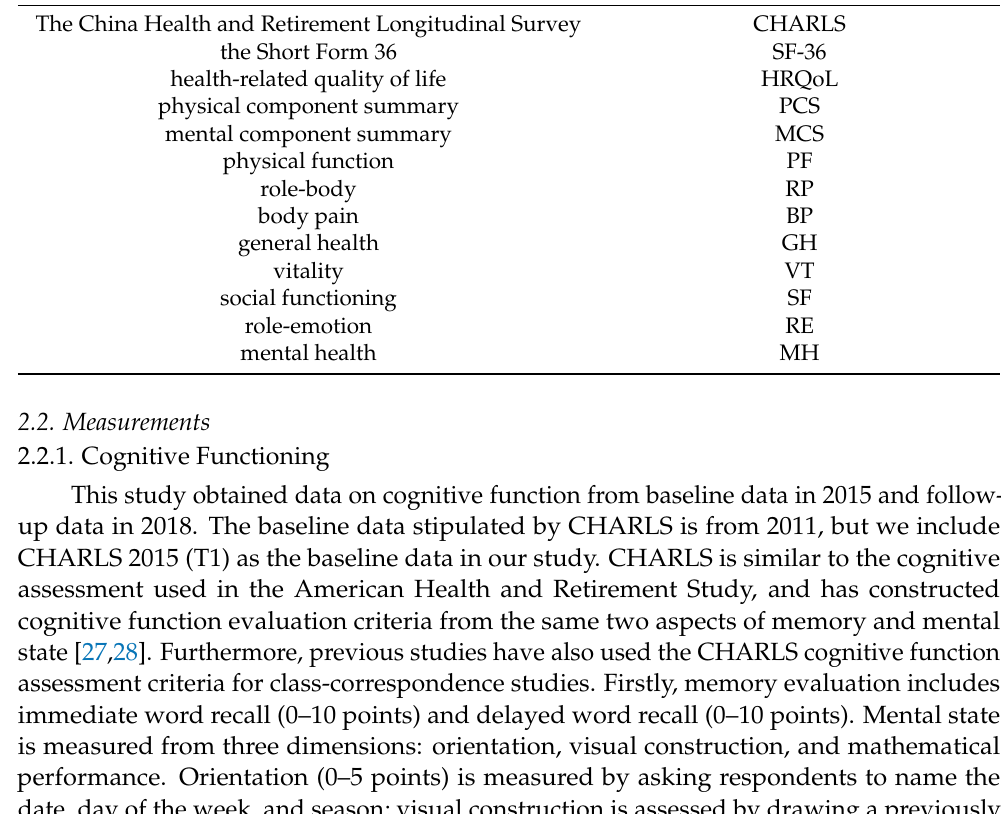
(Table 2): physical function (PF), role–body (RP), body pain (BP), general health (GH), vitality (VT), social functioning (SF), role–emotion (RE), and mental health (MH). The scores for the above eight dimensions were calculated by adding up the category scores and then converting the raw scores to a 0 to 100 scale. Scores from the eight subscales were aggregated into two overall scores according to the conceptual model of the SF-36